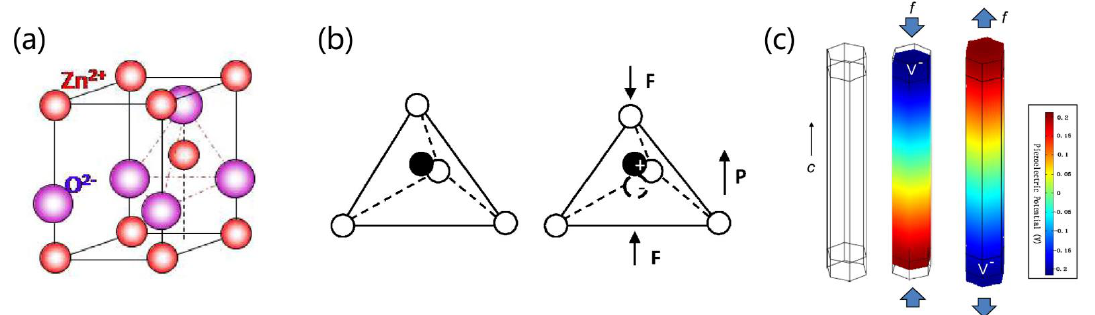
Figure 2. Principle and charge output process of the piezoelectric nanogenerator. ( a ) Model of ZnO’s atomic structure. ( b ) The material’s piezoelectric characteristics and the various piezoelectric potentials under compression and tension, F is the force and P is the piezoelectric potential (piezopotential). Reprinted with permission from [64]. Copyright 2010, Elsevier. ( c ) Diagram of the piezoelectric potential distribution of ZnO, c is the c-axis, which is the growth direction of ZnO nanowires, f is the force, and V is the piezoelectric potential. Reprinted with permission from [65]. Copyright 2009, AIP